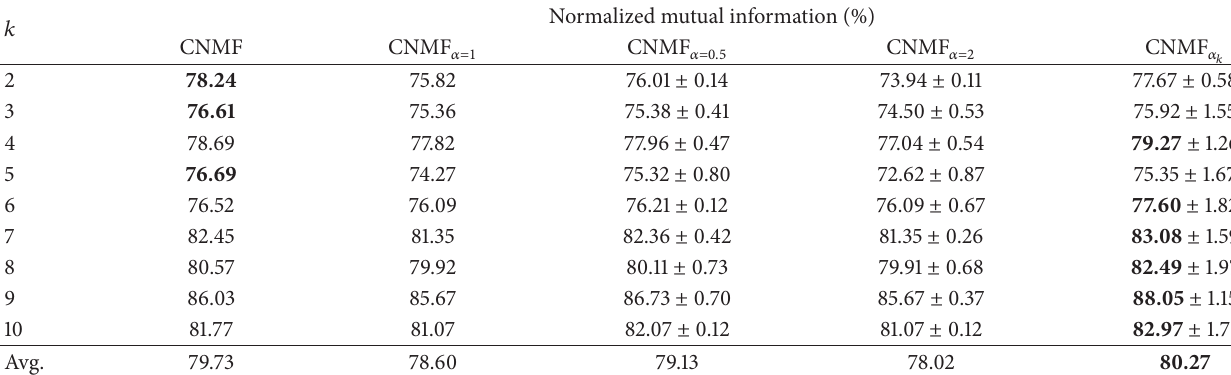
Table 2: The comparison of normalized mutual information on the ORL